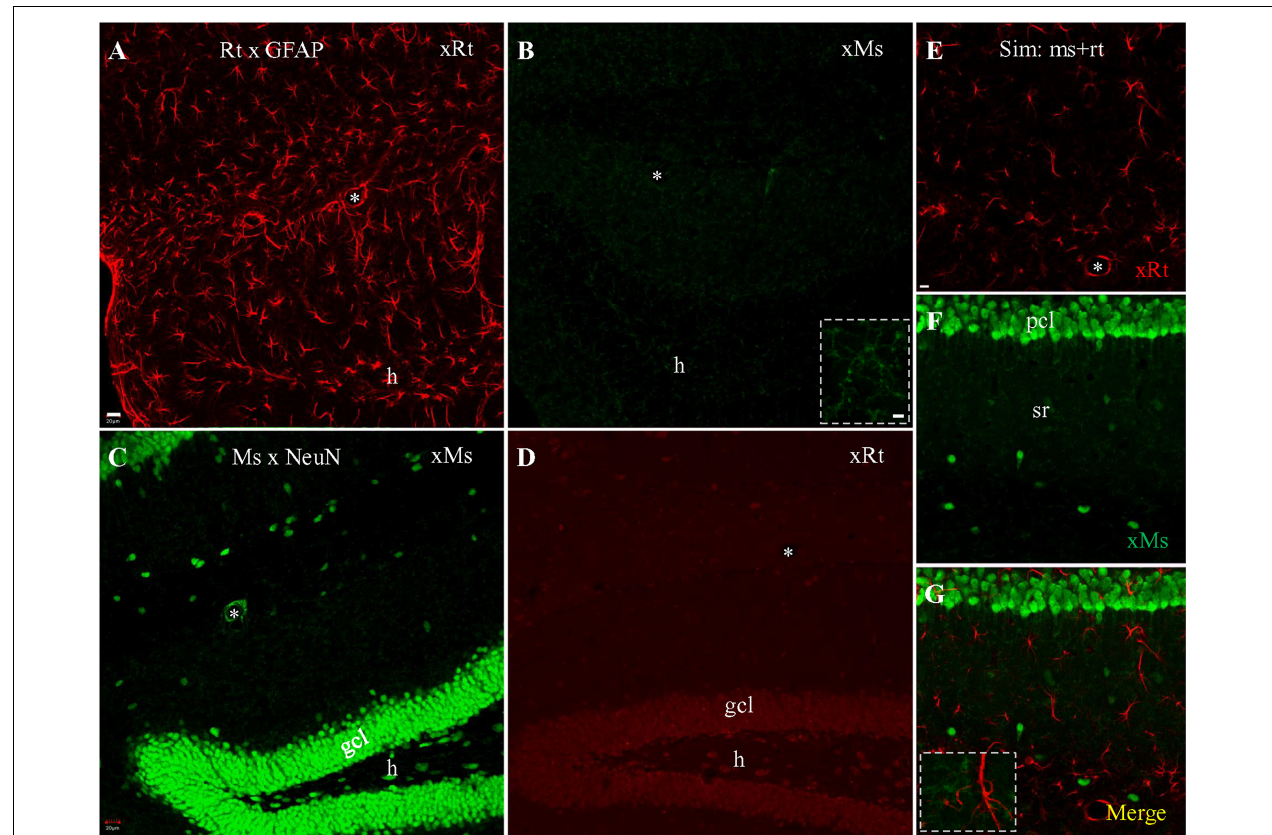
FIGURE 4 | Single and double staining visualized with cross species pre-adsorbed secondaries raised from goat. (A,B) Stack of confocal photomicrographs acquired from the hippocampus stained with rat anti-GFAP primary and visualized with pre-adsorbed goat anti-rat (A) or anti-mouse (B) secondary. Note group of microglia faintly stained in (B) that were prominent under high magnification ( Inset ). (C,D) Stack of photomicrographs after staining with mouse anti-NeuN primary, visualized with cross species pre-adsorbed anti-mouse (C) or anti-rat (D) secondary. (E–G) Confocal photomicrograph showing simultaneous staining with rat anti-GFAP and mouse anti-NeuN primaries, visualized with a mixture of pre-adsorbed anti-rat ( E , red) and anti-mouse ( F , green) secondaries. Note the absence of co-staining of astrocytes or neurons. Distinct apposition of stained astrocytes (red) and microglia (green) could be clearly identified in merged image ( G , Inset ). Asterisks indicating blood vessels in hf. Scale bars: 20 µ m in (A–D) ; 10 µ m in (E–G) ; 5 µ m in Insets